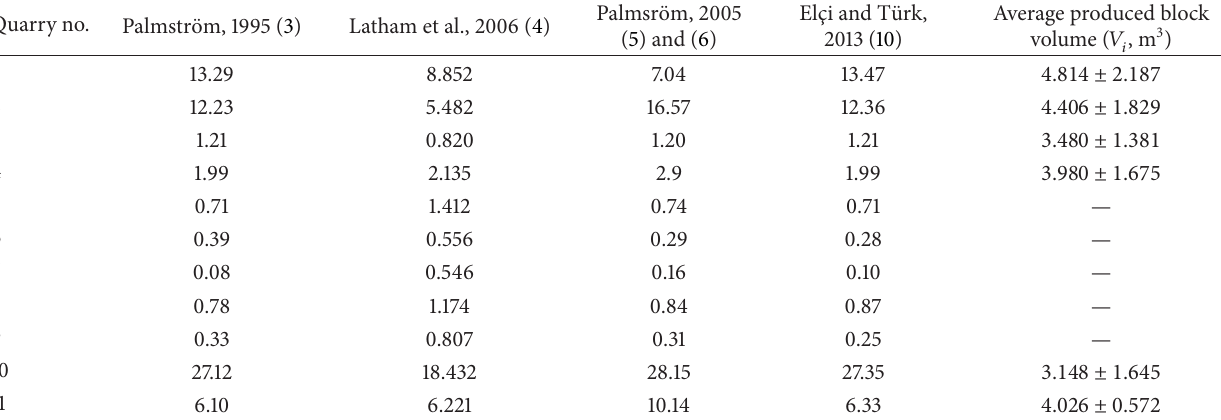
Table 3: Estimated in situ block volume of the Karaburun limestone quarries using the suggested methods in the literature. Quarry no.